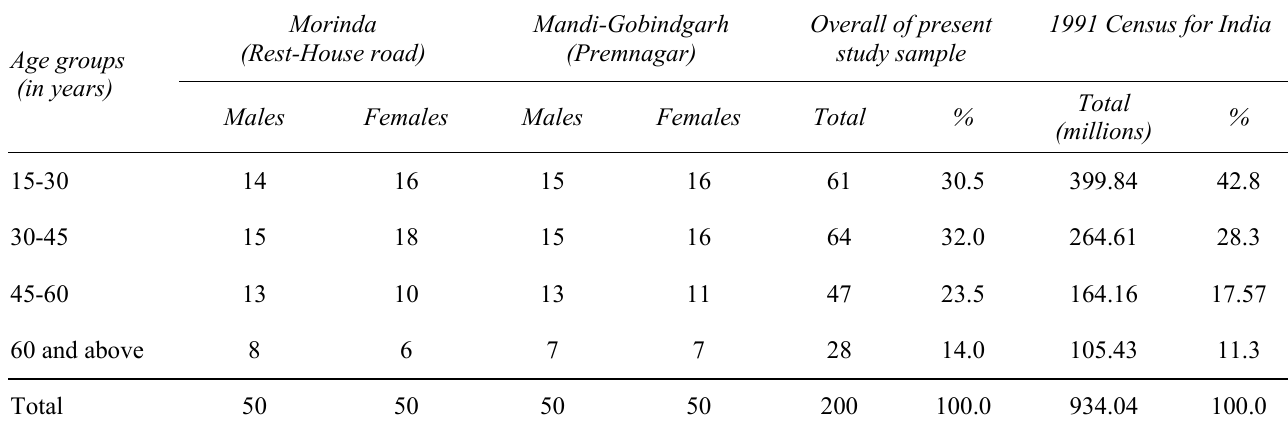
Table 1 : Age-wise breakup of the population sample for the study sites and demographic trends as per 1991